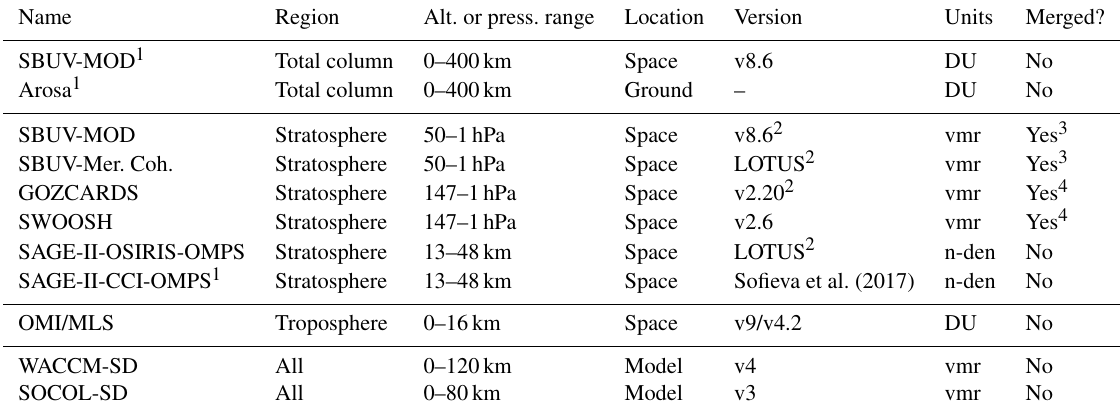
Table 1. List of datasets and coverage considered in this study; some data products cover ranges outside those quoted/used here. Data units are either Dobson units (DU), volume mixing ratio (vmr) in parts per million (ppm), or number density (n-den) in cm − 3